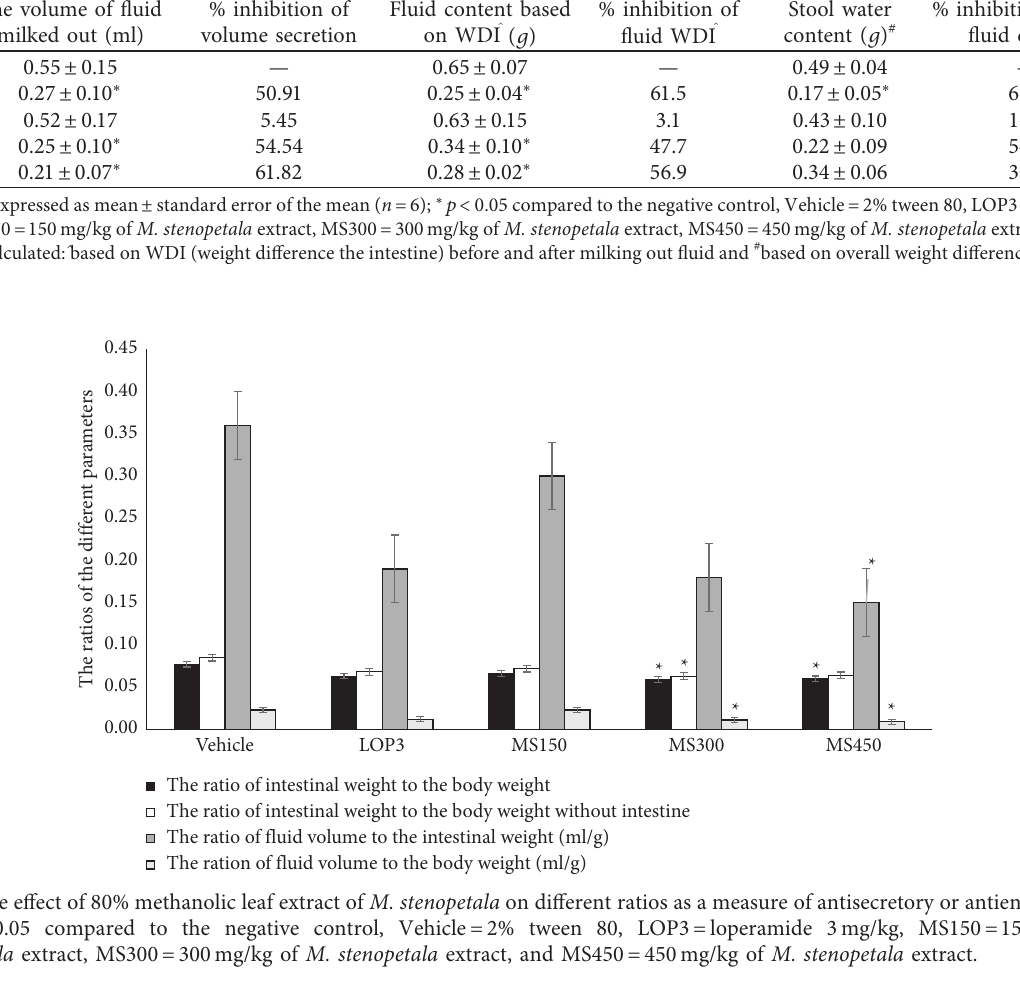
Table 3: The effect of 80% methanolic leaf extract of M. stenopetala on fluid secretion parameters. The volume of fluid % inhibition of Groups milked out (ml) Vehicle